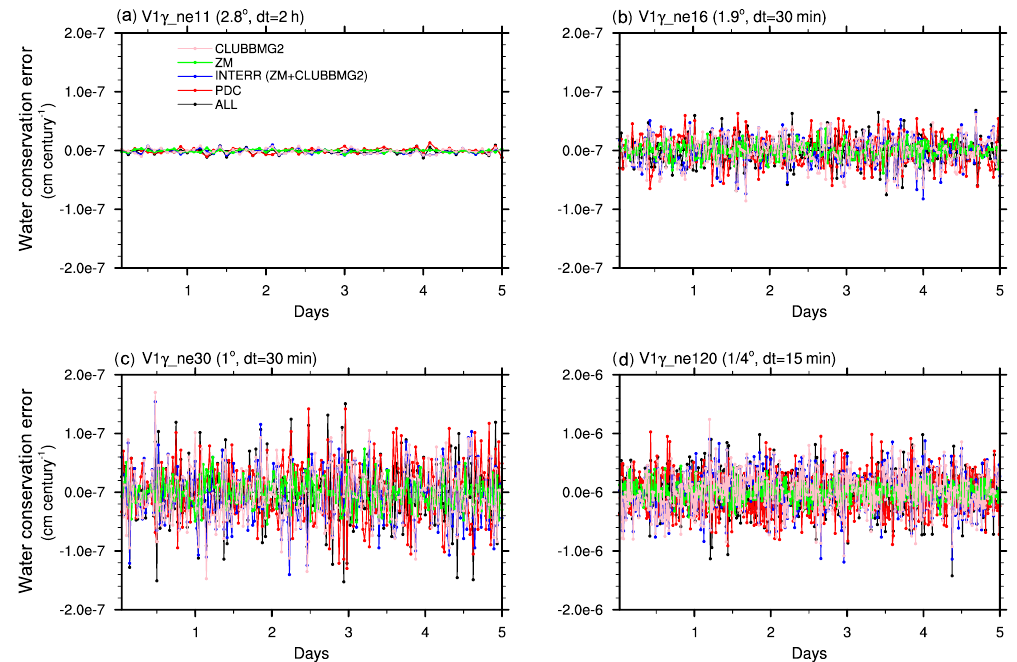
Figure 6. Water conservation error in 5-day simulations conducted with the new E3SM V1 configuration (V1 γ ) at different resolutions. “ZM” and “CLUBBMG2” indicate the internal water conservation error in the Zhang–McFarlane deep convection scheme and in the CLUBB–MG2 schemes